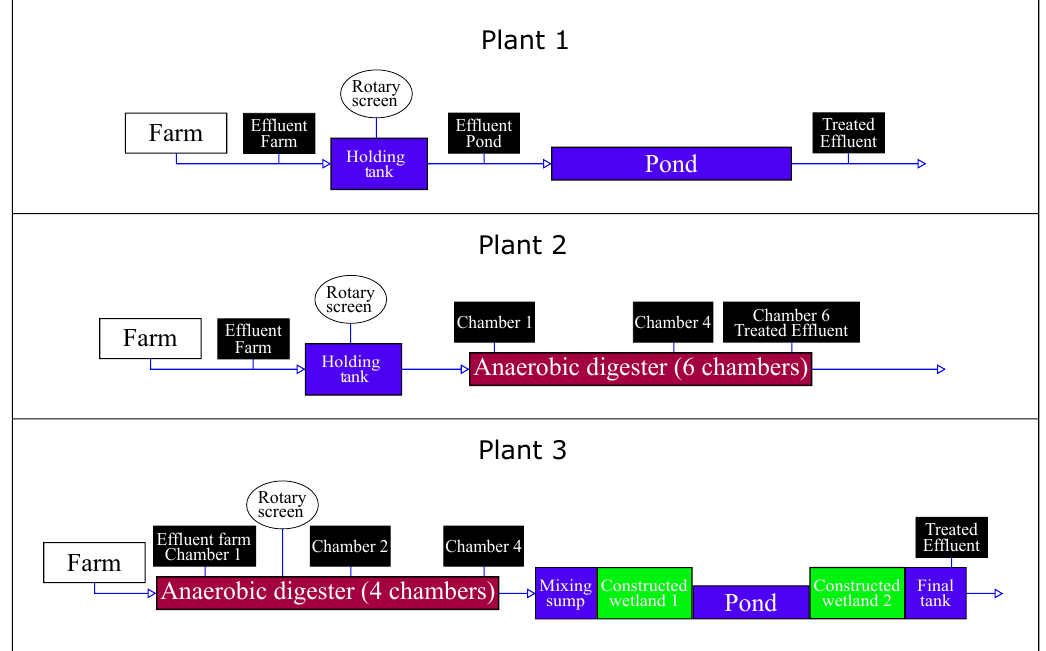
Figure 8. Photograph of Plant 3, with a detail of the pond, and the constructed wetlands.